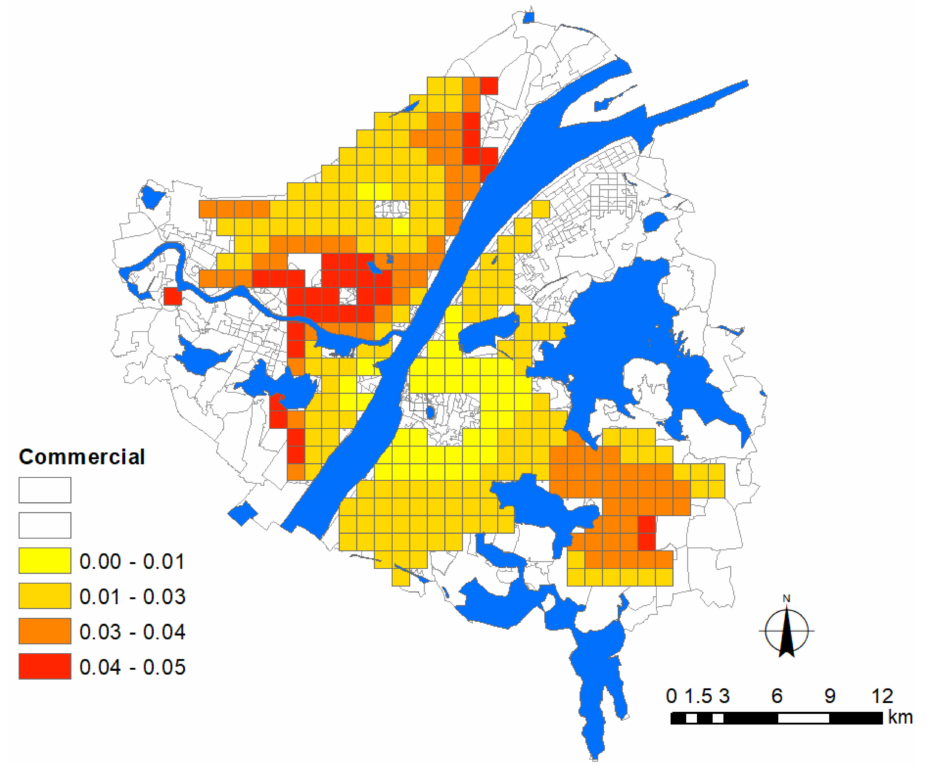
Figure 8. Areas significantly a ff ected by the commercial facilities. The legend denotes the corresponding intensity of